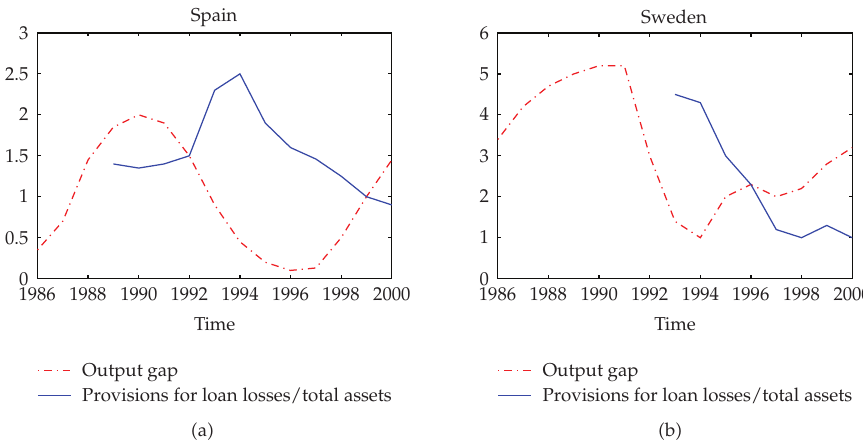
Figure 2: Output gap versus provisions for loan losses-to-total assets ratio for Spain and Sweden (cid:2) 1986– 2000 (cid:3)